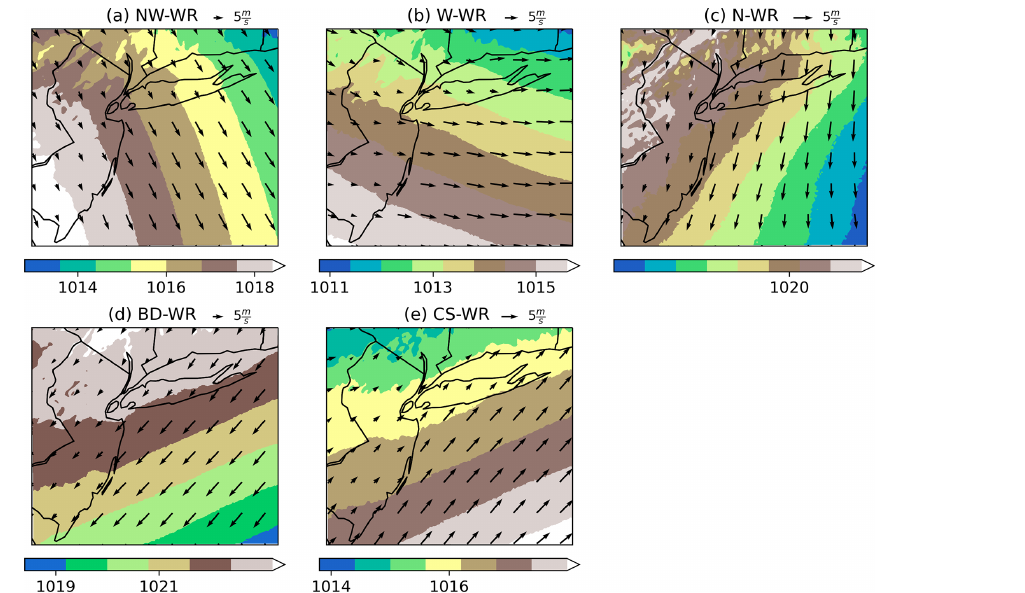
Figure 4. Spatial patterns of the averaged sea level pressure (mbar), 10m wind speed (ms − 1 ) and wind direction for the five different wind regimes at 08:00LT: (a) composite average for the northwesterly wind regime (NW-WR), (b) composite average for the westerly wind regime, (c) composite average for the northerly wind regime (N-WR), (d) composite average for the backdoor sea breeze wind regime (BD-WR) and (e) composite average for the corkscrew sea breeze wind regime (CS-WR).